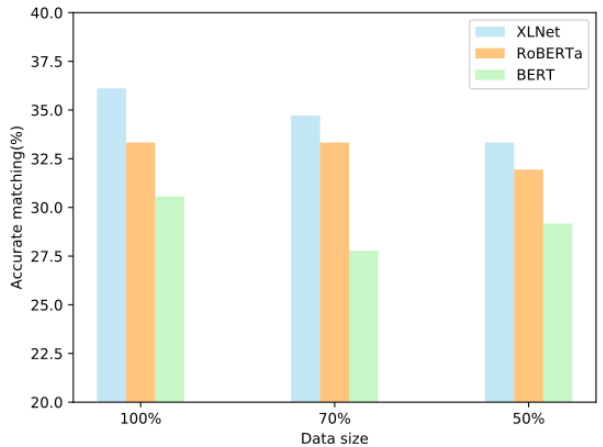
Figure 7. Data sampling